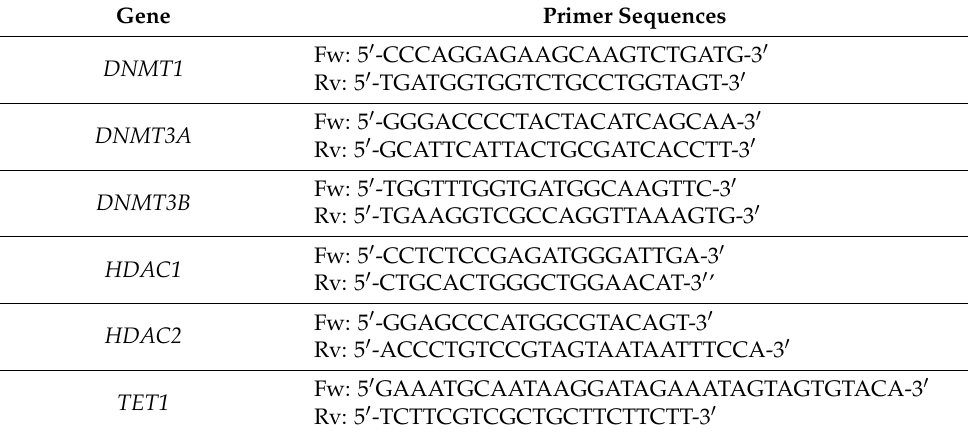
Table 3. Sequences of primers used in the RT-qPCR assay in sheep. Fw = Forward primer and Rv = Reverse